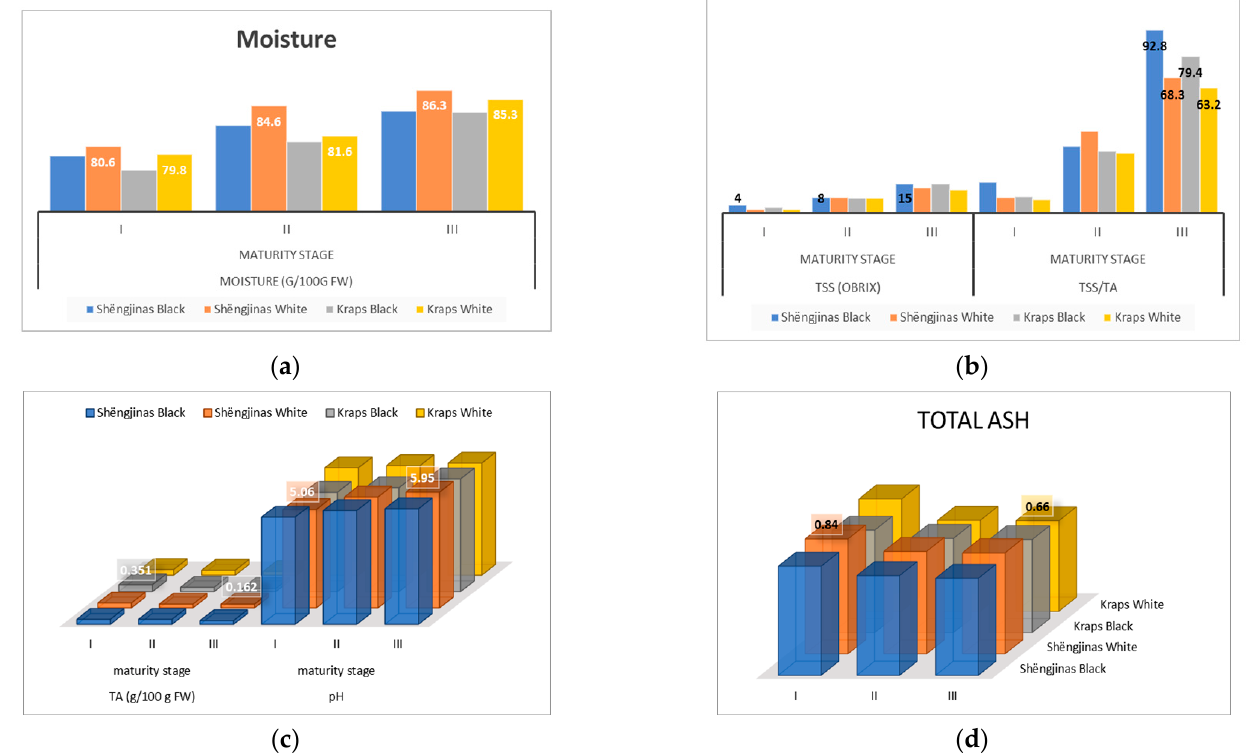
Figure 1. Shëngjinas and Kraps fig varieties (black and white) (g/100 g FW) in three maturity stages: ( a ) moisture content; ( b ) total soluble solids (°Brix) and TSS/TA; ( c ) total acidity and pH; ( d ) total ash.